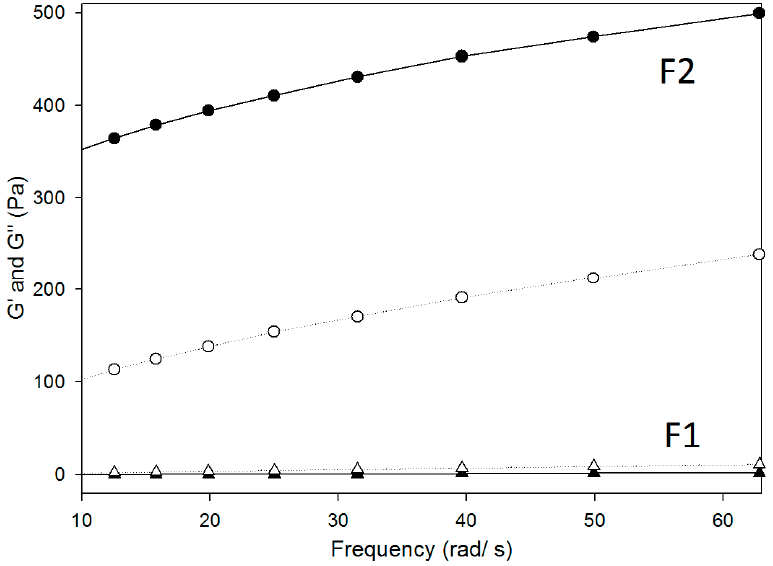
Figure 6. Frequency sweep profile of storage and loss moduli G’ and G” (closed and opened symbols), respectively, of systems composed of poloxamer 407 dispersion (1%), oleic acid, and PPG-5-CETETH-20. Data were collected at 37 ± 0.5 °C.